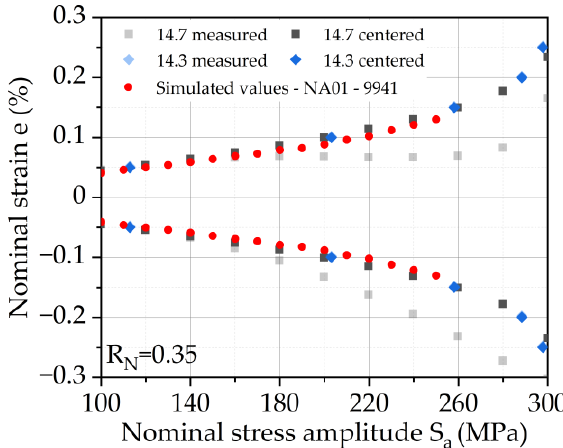
Figure 12. Comparison of simulated load increase test of a specimen with R N = 0.35 mm using Chaboche parameter set for tests conducted at RT, with measured data of a nominal LIT (Specimen 14.7) and a nominal SIT (Specimen 14.3).